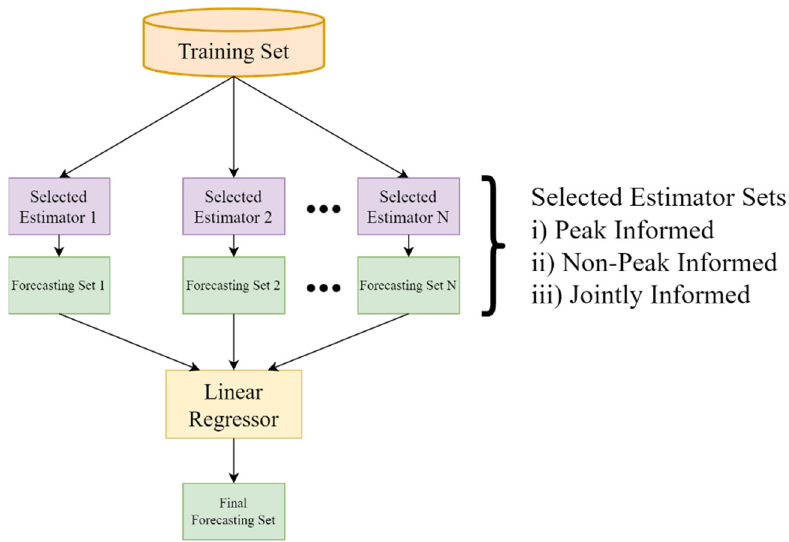
Figure 6. Stacking ensemble structure based on the peak and non-peak member selection strategy.